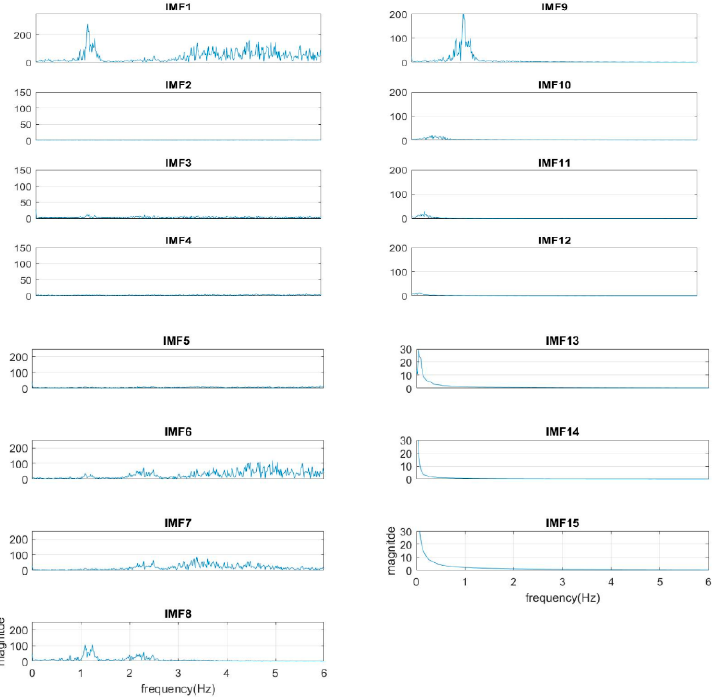
Figure 10. The spectra of IMFs with a sample rate of 500 Hz (same as the sample in Figure 3).